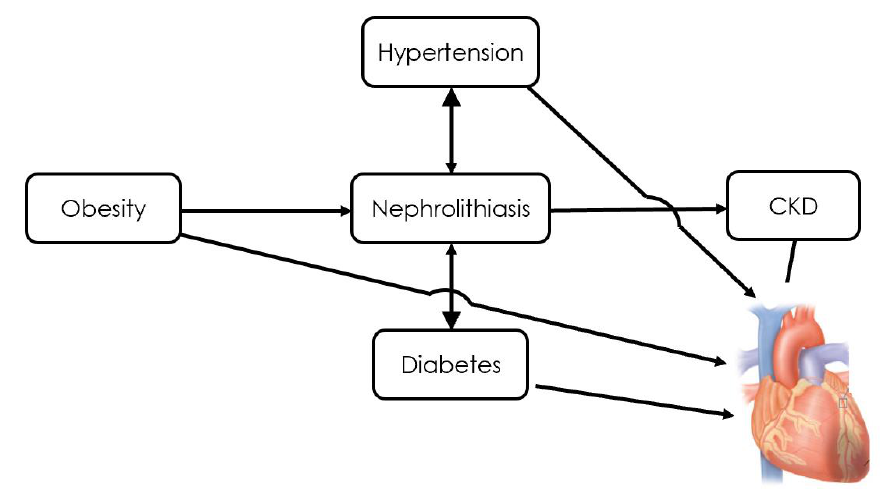
Figure 1. Nephrolithiasis and CV risk factors.